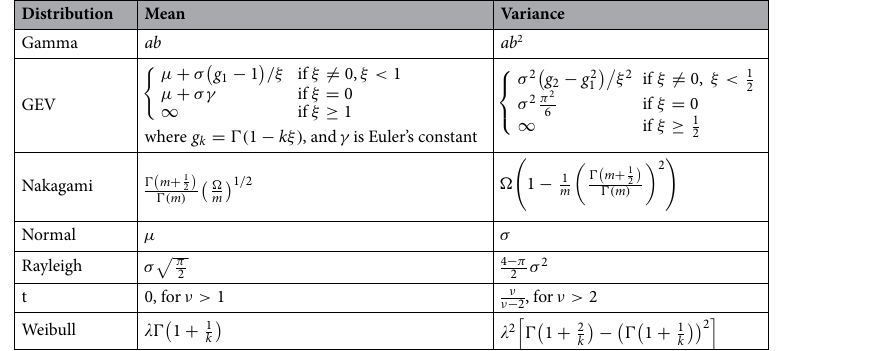
Table 3. The mean and variance expressions of